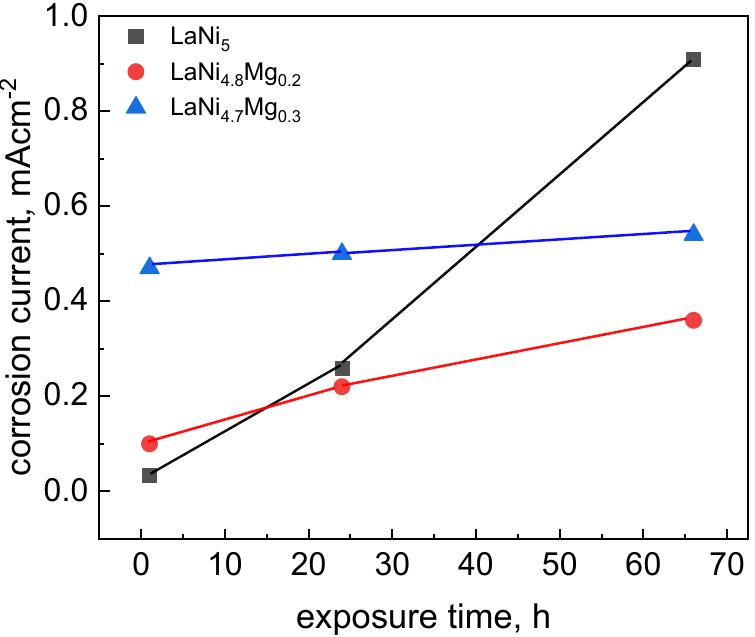
Figure 4. Corrosion rate dependence on exposure time in 6M KOH solution for LaNi 5-x Mg x alloys (x = 0, 0.2, and 0.3).